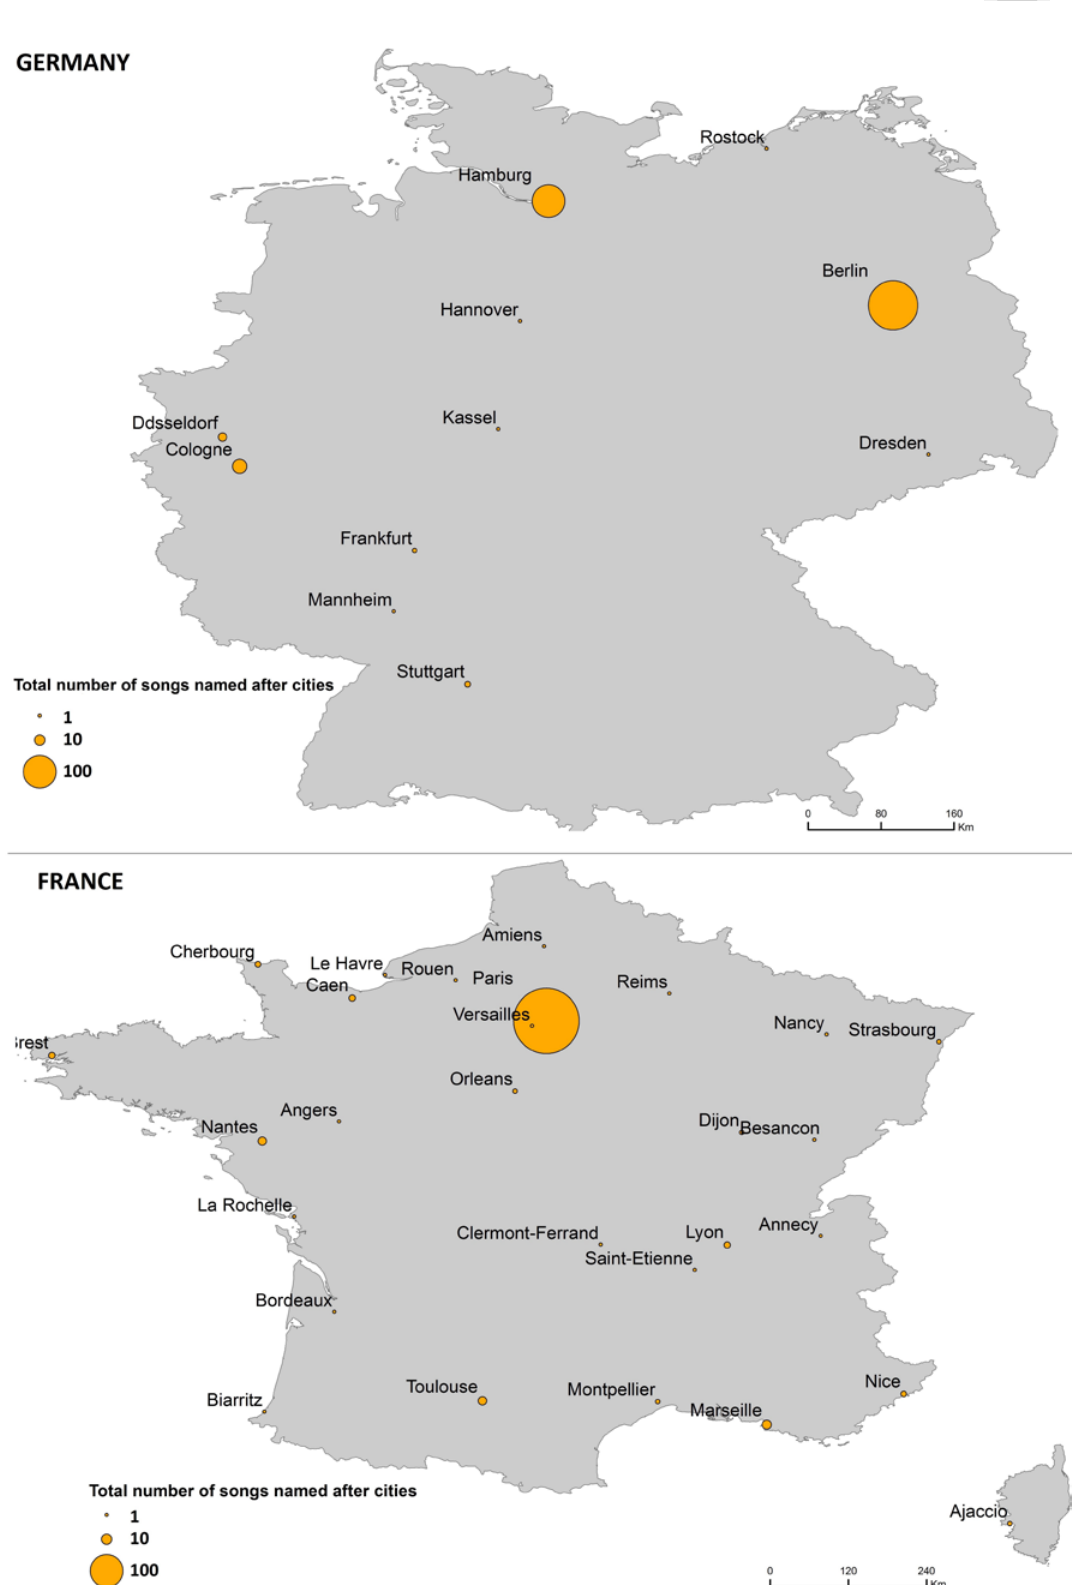
Figure 8: Songs named after cities in Germany and France Source: Own map based on JUCU Database